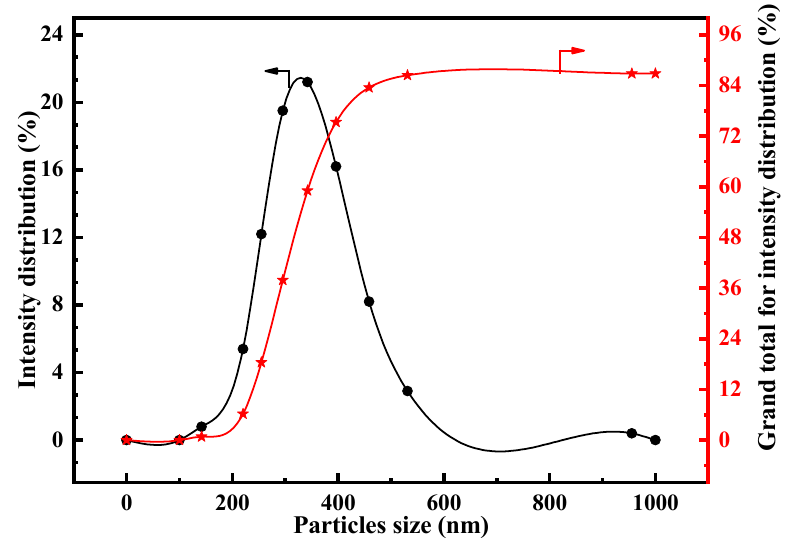
Figure 4. The particle size distribution of BCFA using a laser particle size analyzer.